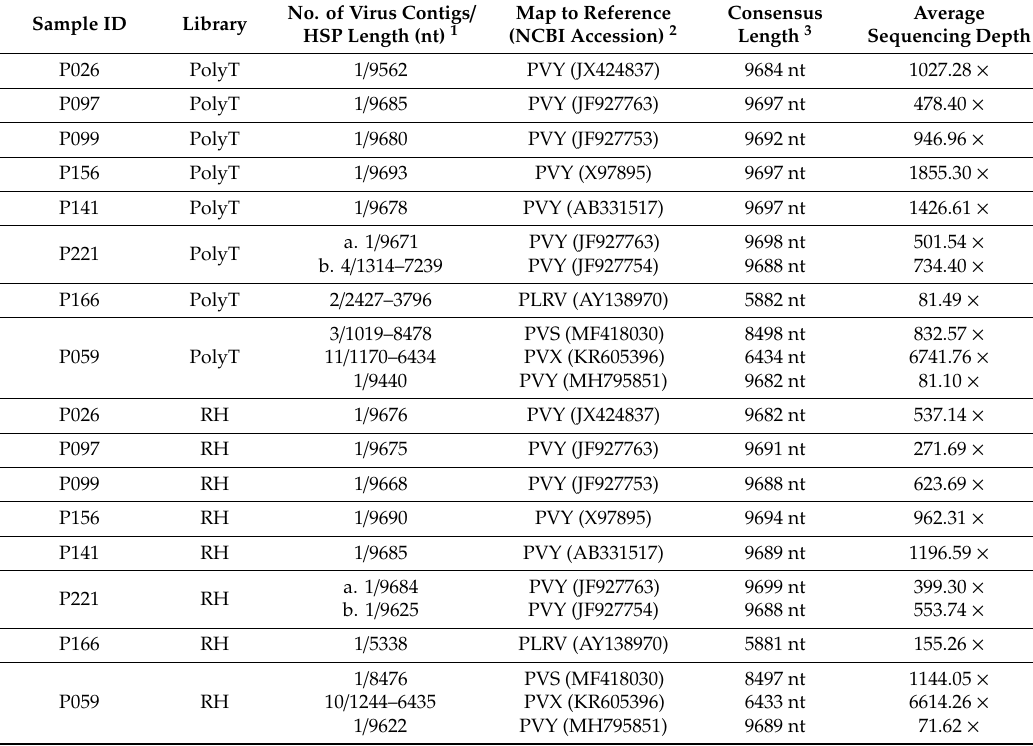
Table 4. Summary of nanopore sequencing and assembling